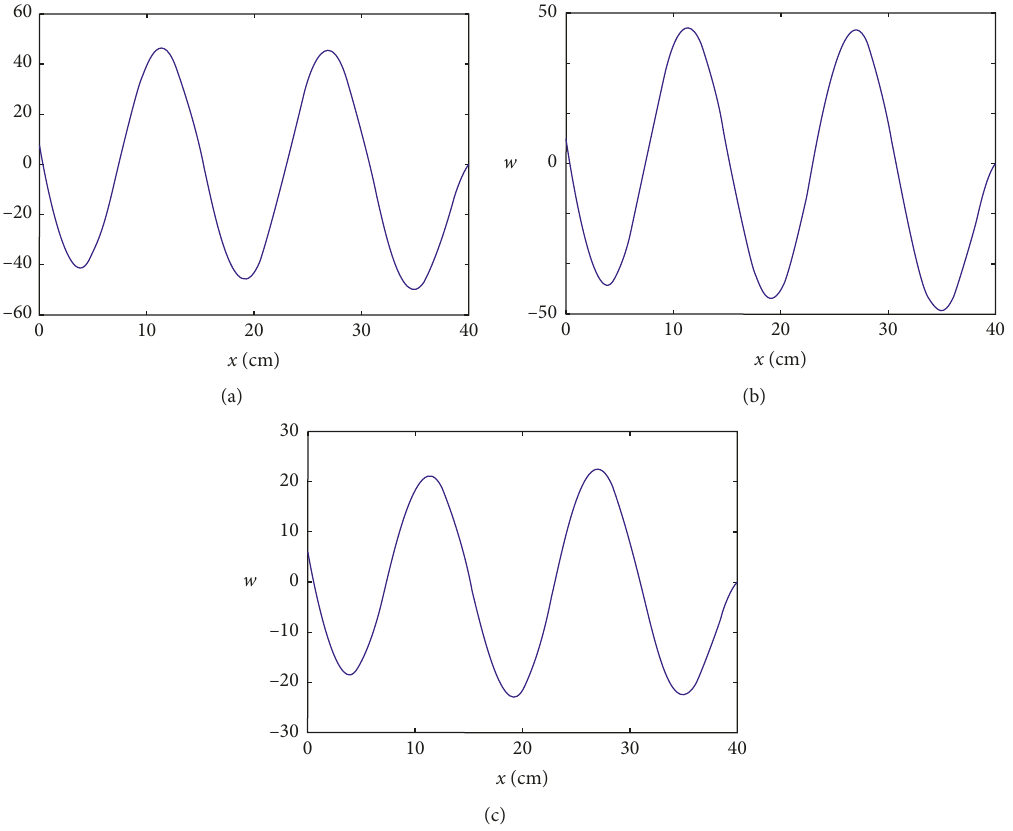
Figure 10: Mode shapes of ABH beams with different damping layer thickness at around 9kHz: (a) h � 1mm, frequency � 9141.59Hz; (b) h � 2mm, frequency � 9158.9Hz; (c) h � 3 mm, frequency � 9158.22Hz.